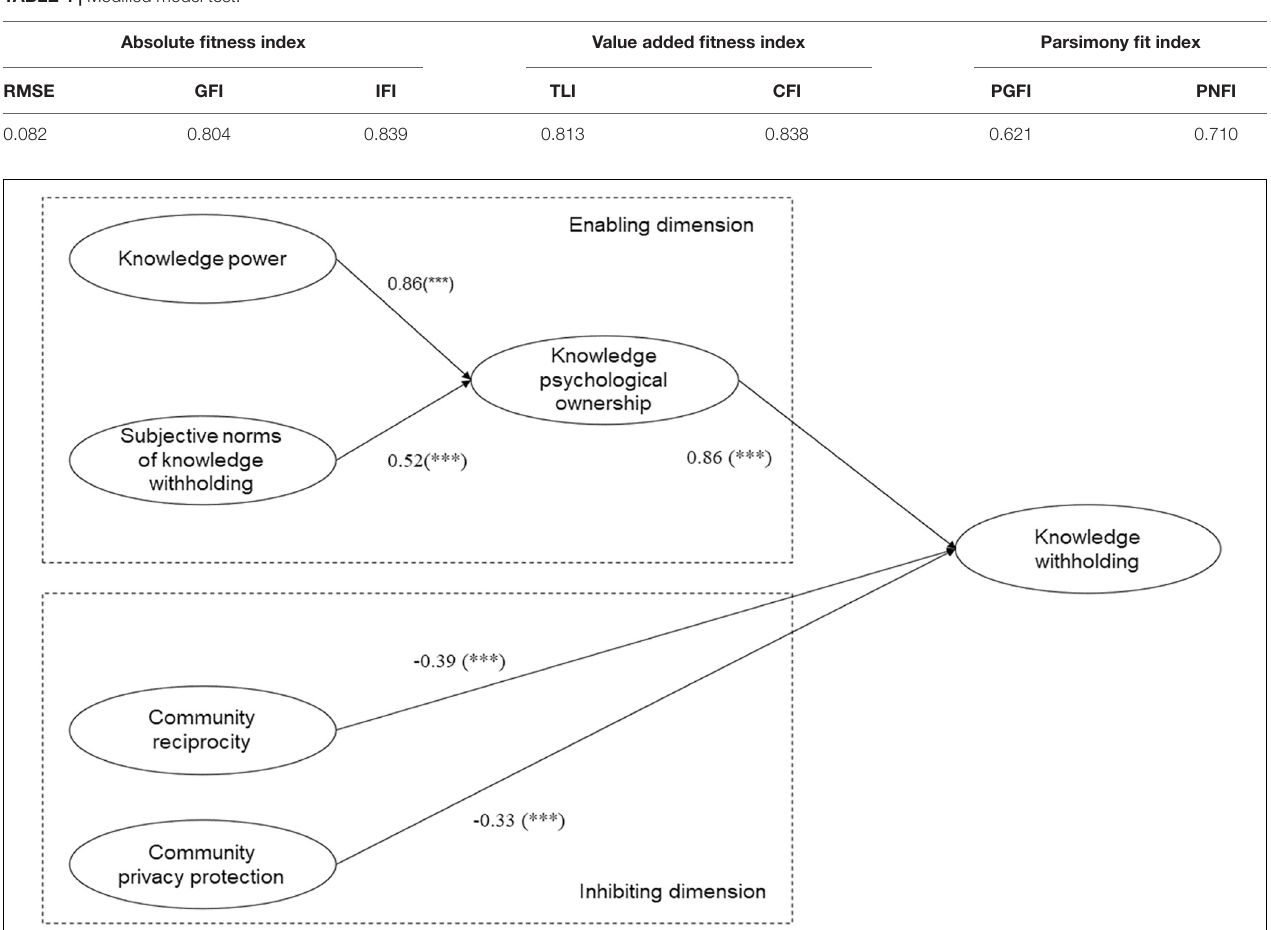
TABLE 4 | Modified model test.